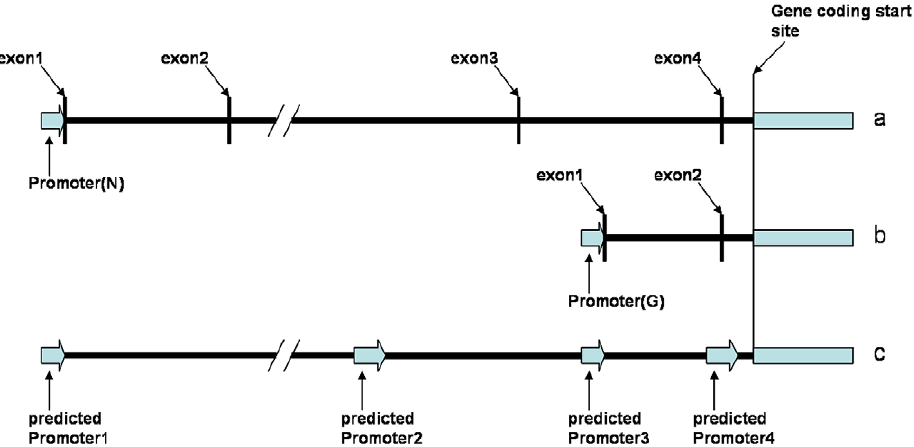
Fig. 1A. A schematic representation of the promoters and 5 (cid:2) flanking regions of human IL-13Ra2 gene. Promoters are indicated as gray arrows, the exons in the 5 (cid:2) flanking area before the gene coding start site are indicated as black boxes. (a) Promoter N. (b) Promoter G. (c) Promoters predicted by using online software Gene2promoter. Promoter N is matched with the predicted promoter 1 and promoter G is matched with the predicted promoter 3.